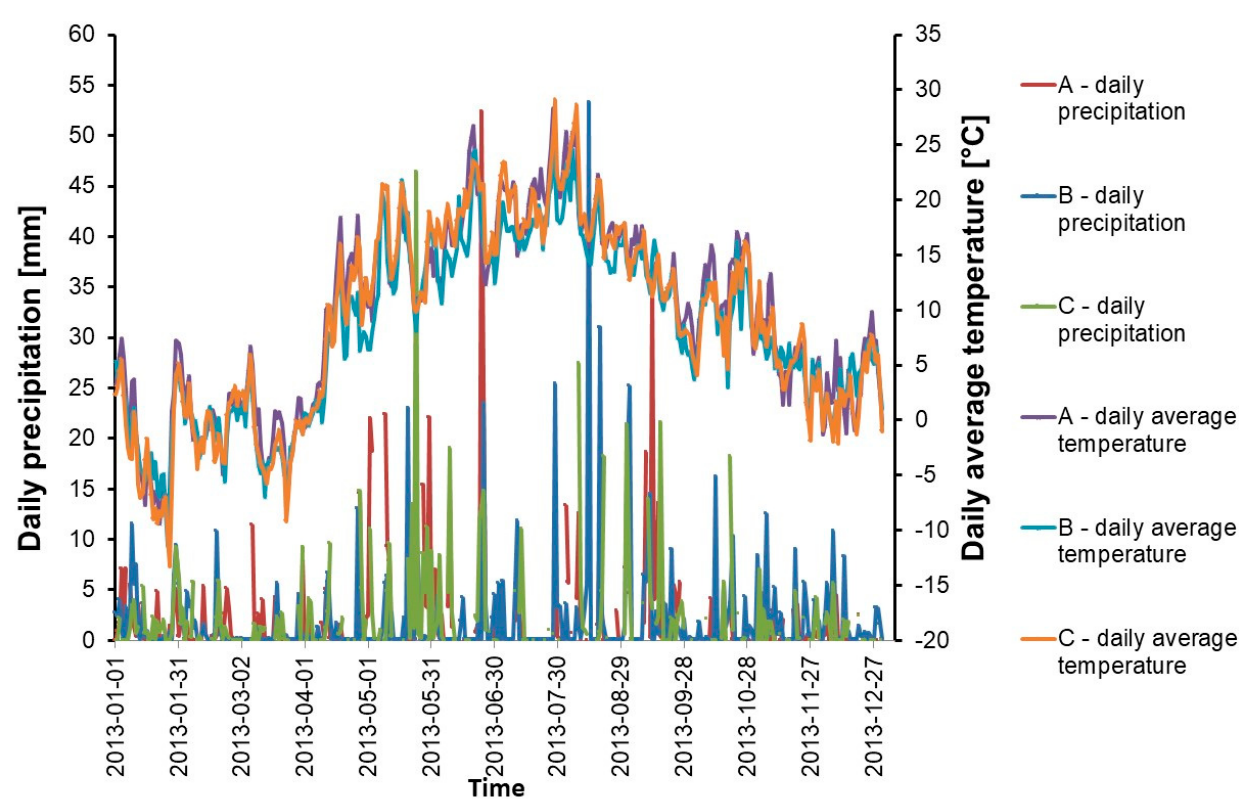
Figure 3. Meteorological data for the A, B, C experimental sites in the year of the research: A − Chociwel in Lower Silesian Voivodship; B − Damno in Pomeranian Voivodship, C − Imielin in Masovian Voivodship. Table 2. Characteristics of the study sites and